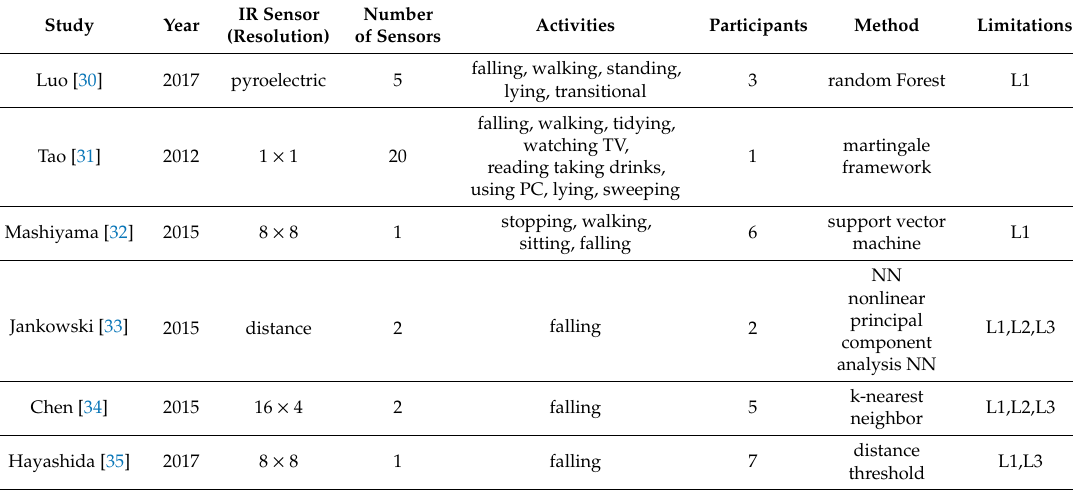
Table 1. Comparison with other studies using infrared